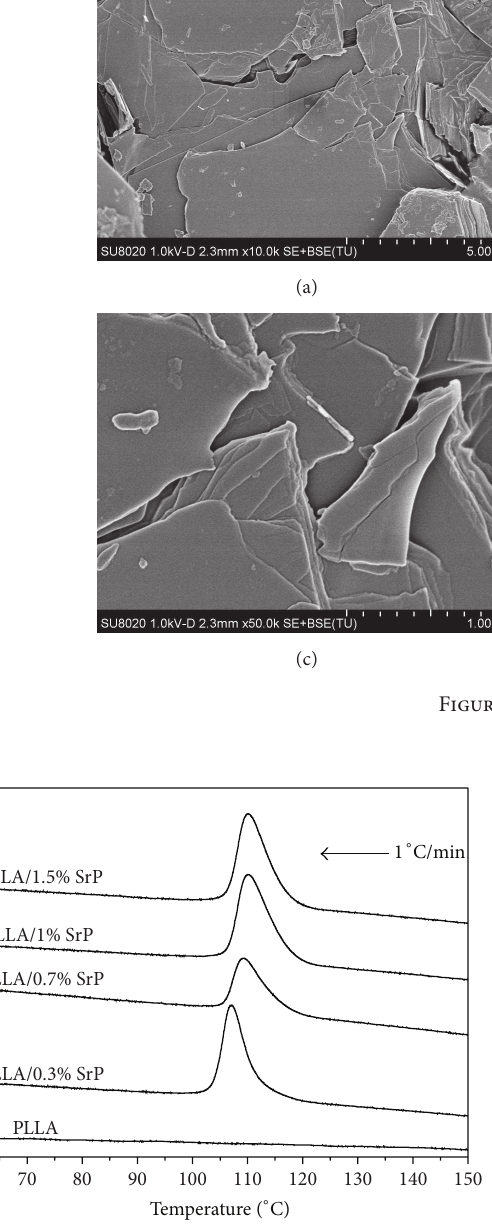
Figure 3: DSC curves of PLLA and PLLA/SrP samples at a cooling rate of 1 ∘ C/min.